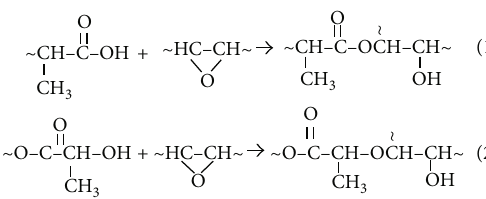
Figure 8: Reactions between epoxy groups of epoxidized oil and carboxyl (2) or hydroxyl (3) end of PLA